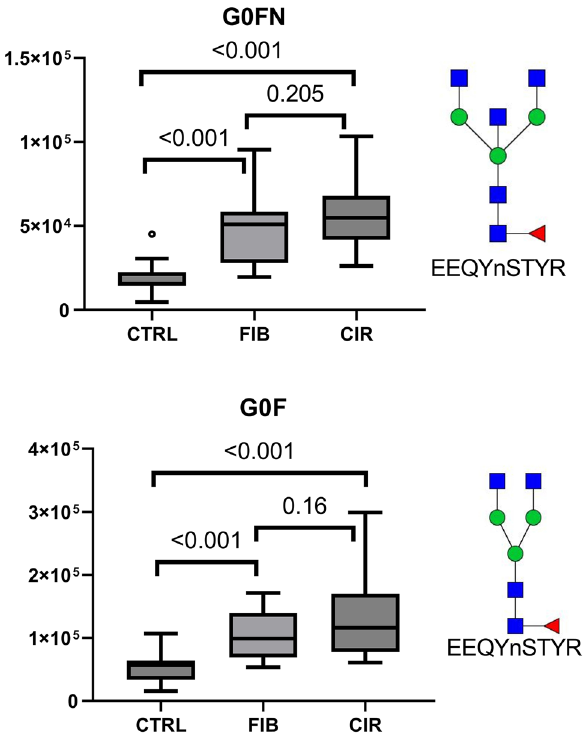
Figure 3. Quantification of the IgG glycoforms in control (CTRL n = 15), fibrosis (FIB n = 15), and cirrhosis (CIR n = 15) patients. IgG1 N-glycoforms G0FN, and G0F increase significantly in the fibrotic patients compared to the control group. The blue rectangle represents HexNAc (GlcNAc), green circle Hex (Man), and red triangle Fuc.